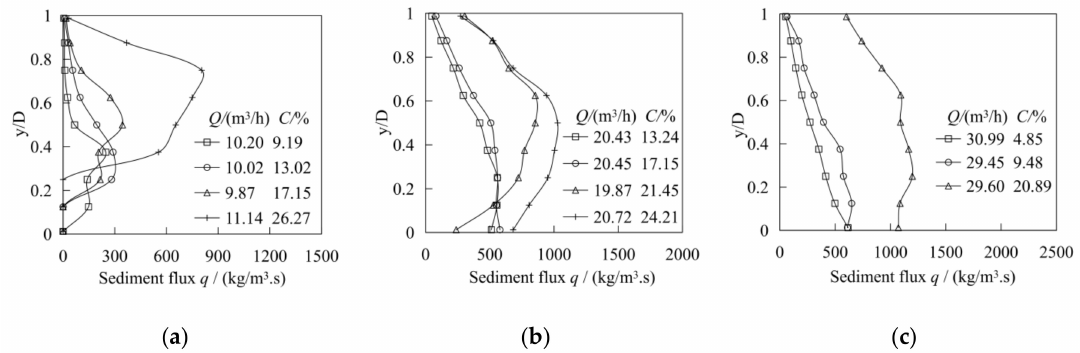
Figure 12. Distribution of sediment transport flux per unit width: ( a ) Q = 9.87–11.14 m 3 /h; ( b ) Q = 19.87–20.72 m 3 /h; and ( c ) Q = 29.45–30.99 m 3